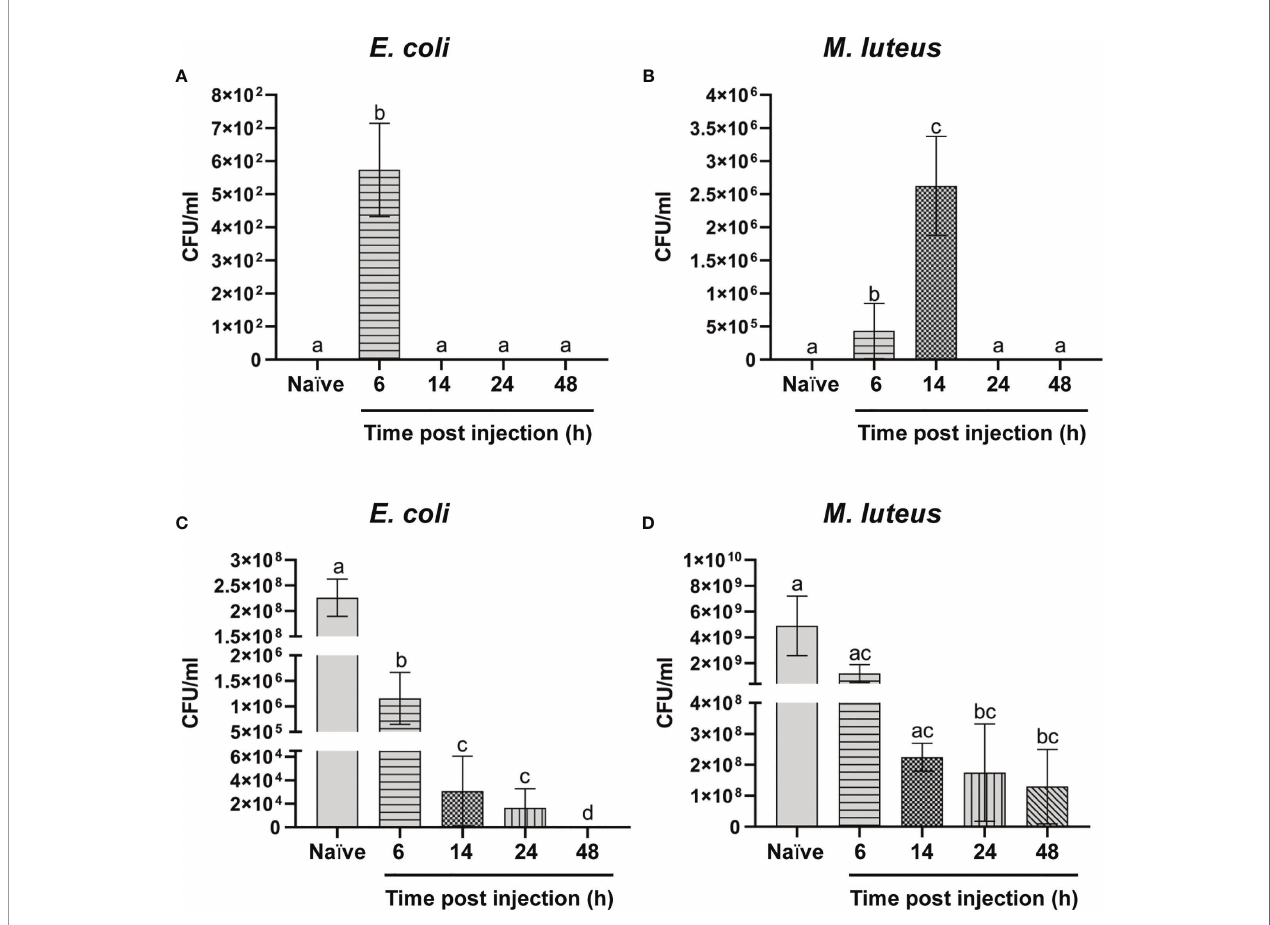
FIGURE 1 | Analysis of the antimicrobial activity. (A, B) Humoral and cellular activity against Escherichia coli (A) and Micrococcus luteus (B) . (C, D) Humoral antimicrobial activity against E. coli (C) and M. luteus (D) . Values represent mean ± s.e.m. Different letters indicate statistically signi fi cant differences among treatments (One-Way ANOVA: A ) F 4-10 = 91.65, p < 0.0001; B ) F 4-10 = 74.62, p < 0.0001; C ) F 4-10 = 52.36, p < 0.0001; D ) F 4-10 = 4.694, p <